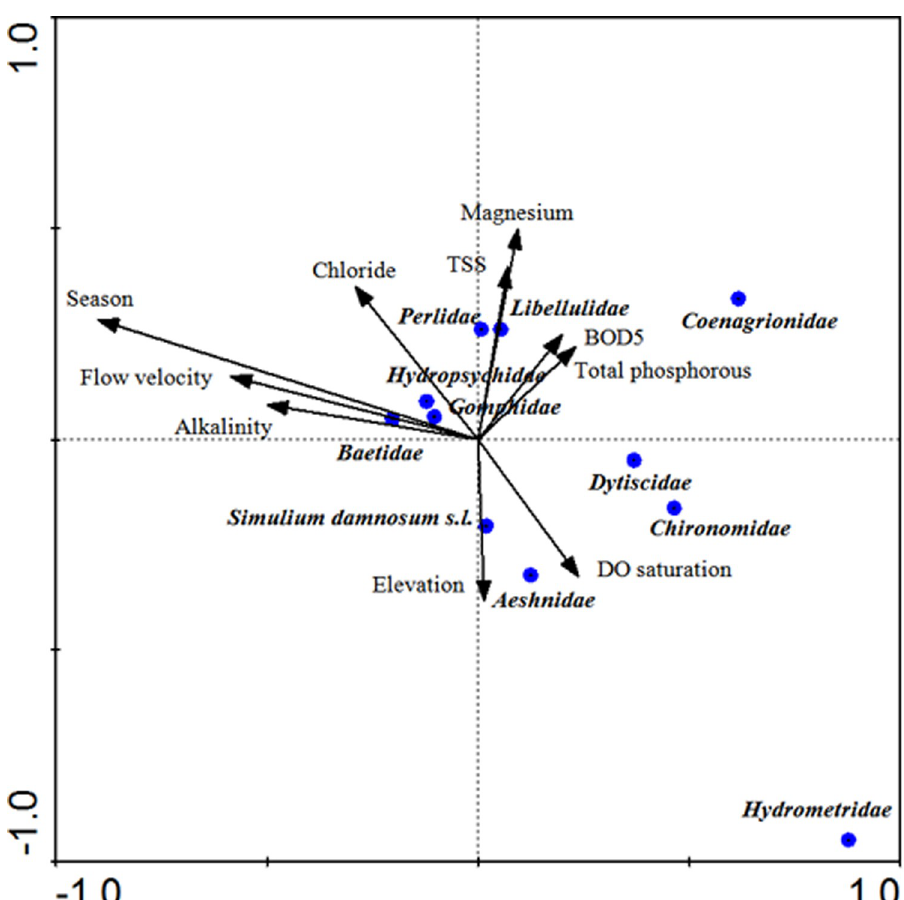
Fig 4. Canonical Correspondence Analysis (CCA) of S . damnosum larvae and biological and environmental variables in Omo Gibe river basin. pH: Logarithmic measure of hydrogen ion concentration; DO: Dissolved Oxygen; TSS: Total Suspended Solids; TDS: Total Dissolved Solids; BOD5: Five-day Biological Oxygen